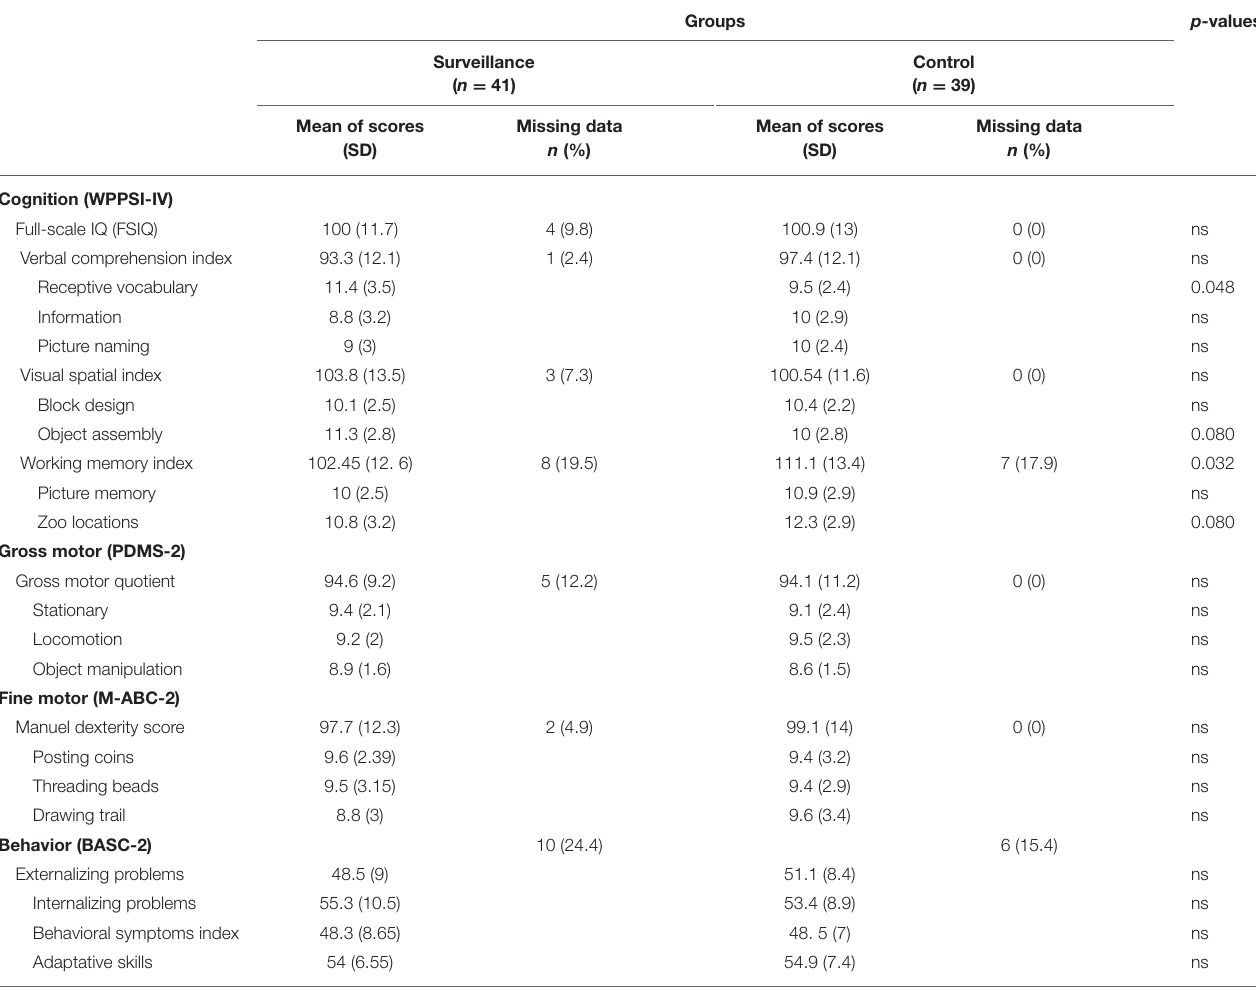
TABLE 3 | Neurodevelopmental outcome of children with CHD.